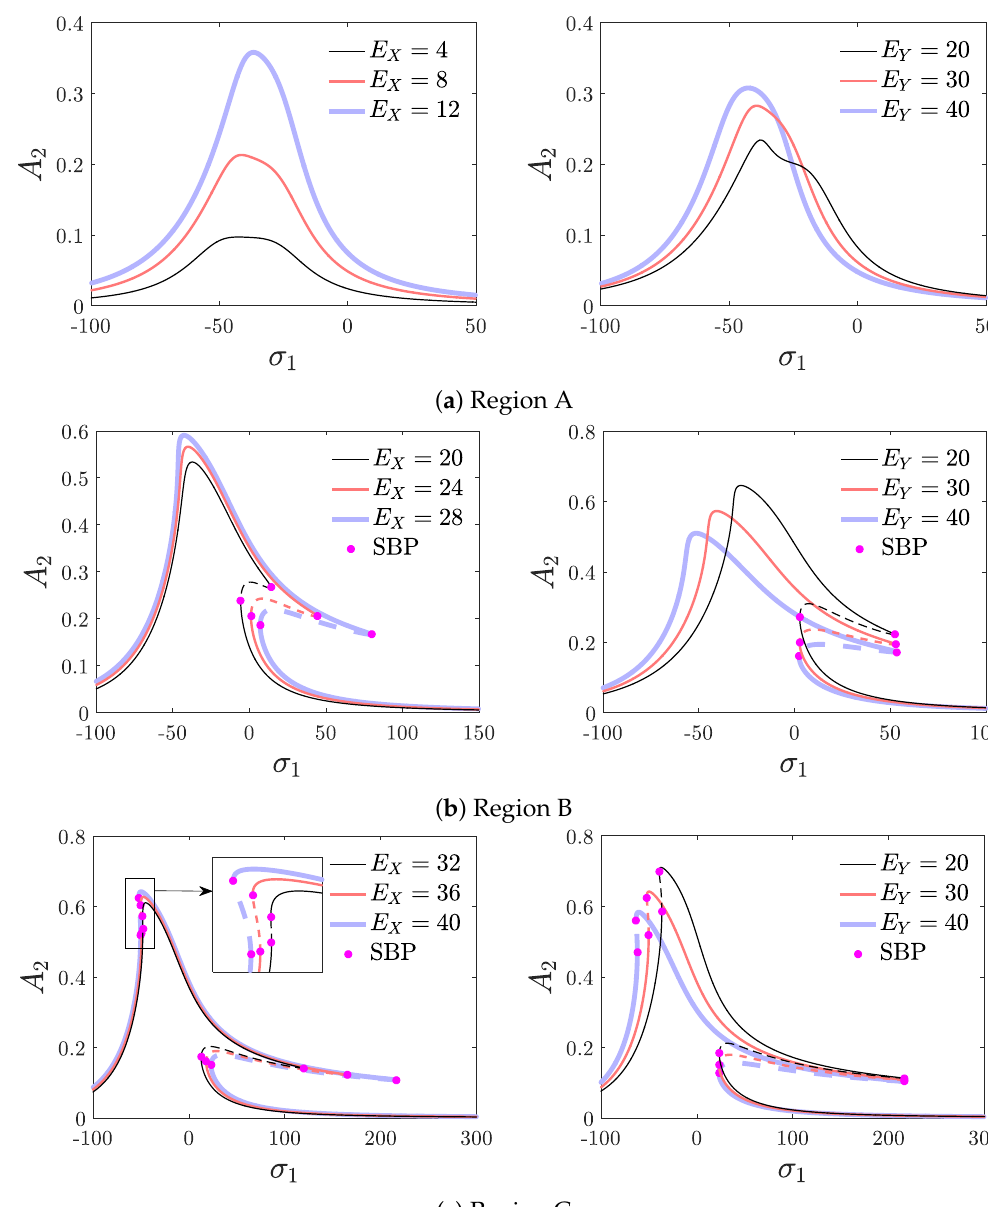
Figure 11. Influences of driving and detecting voltages on the amplitude–frequency curves; Region A: E X = 10, E Y = 30, Region B: E X = 25, E Y = 30, and Region C: E X = 40, E Y =